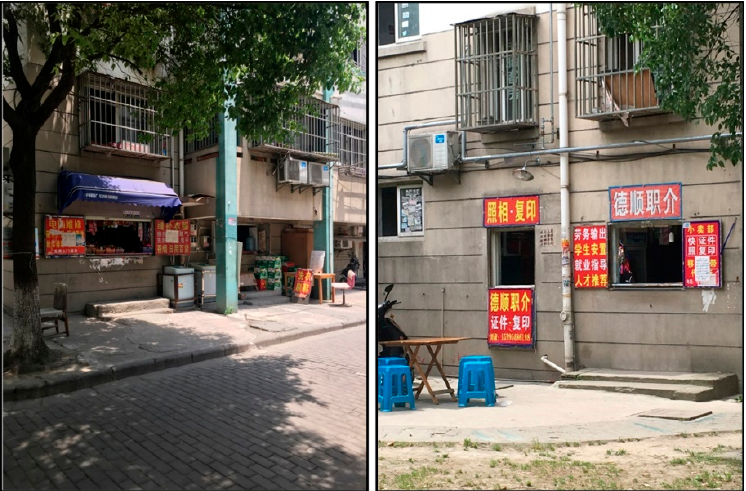
Figure 7. Consumption space of Qunyi Community.